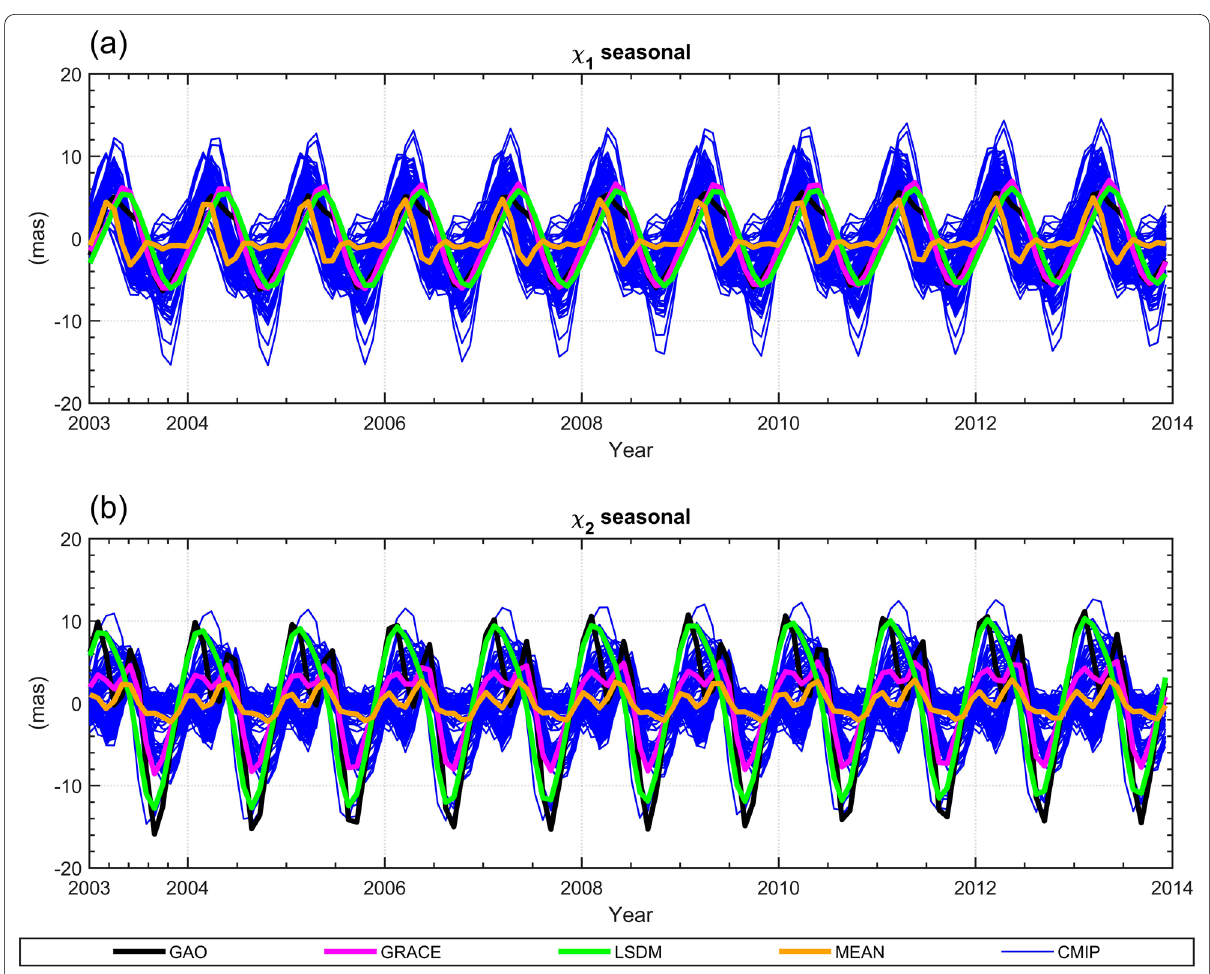
Fig. 4 a χ 1 and b χ 2 components of seasonal oscillations in GAO and HAM computed from GRACE, LSDM, CMIP6 models and MEAN